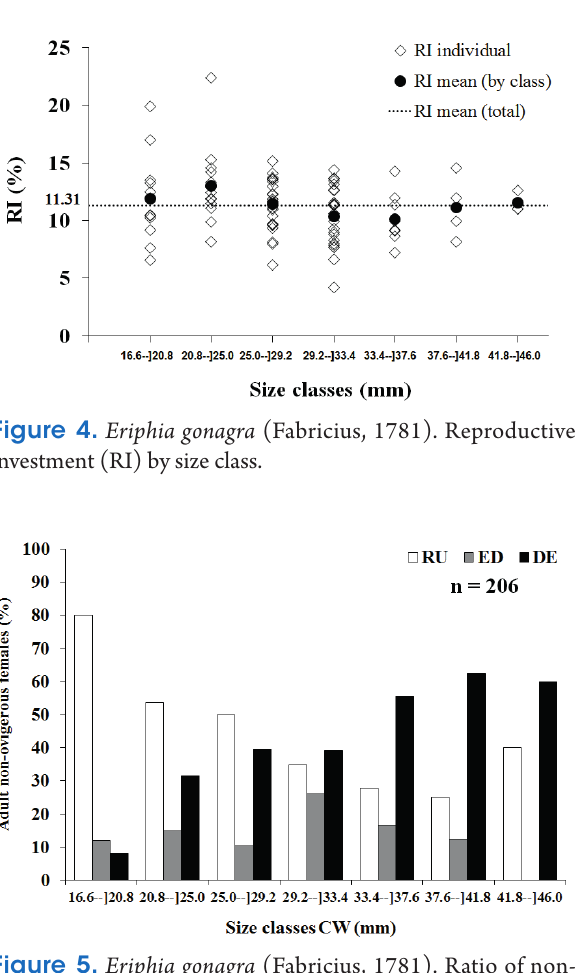
Figure 5. Eriphia gonagra (Fabricius, 1781). Ratio of non- ovigerous adult females in the different gonad stages, by size class (RU = rudimentary, ED = developing, DE =